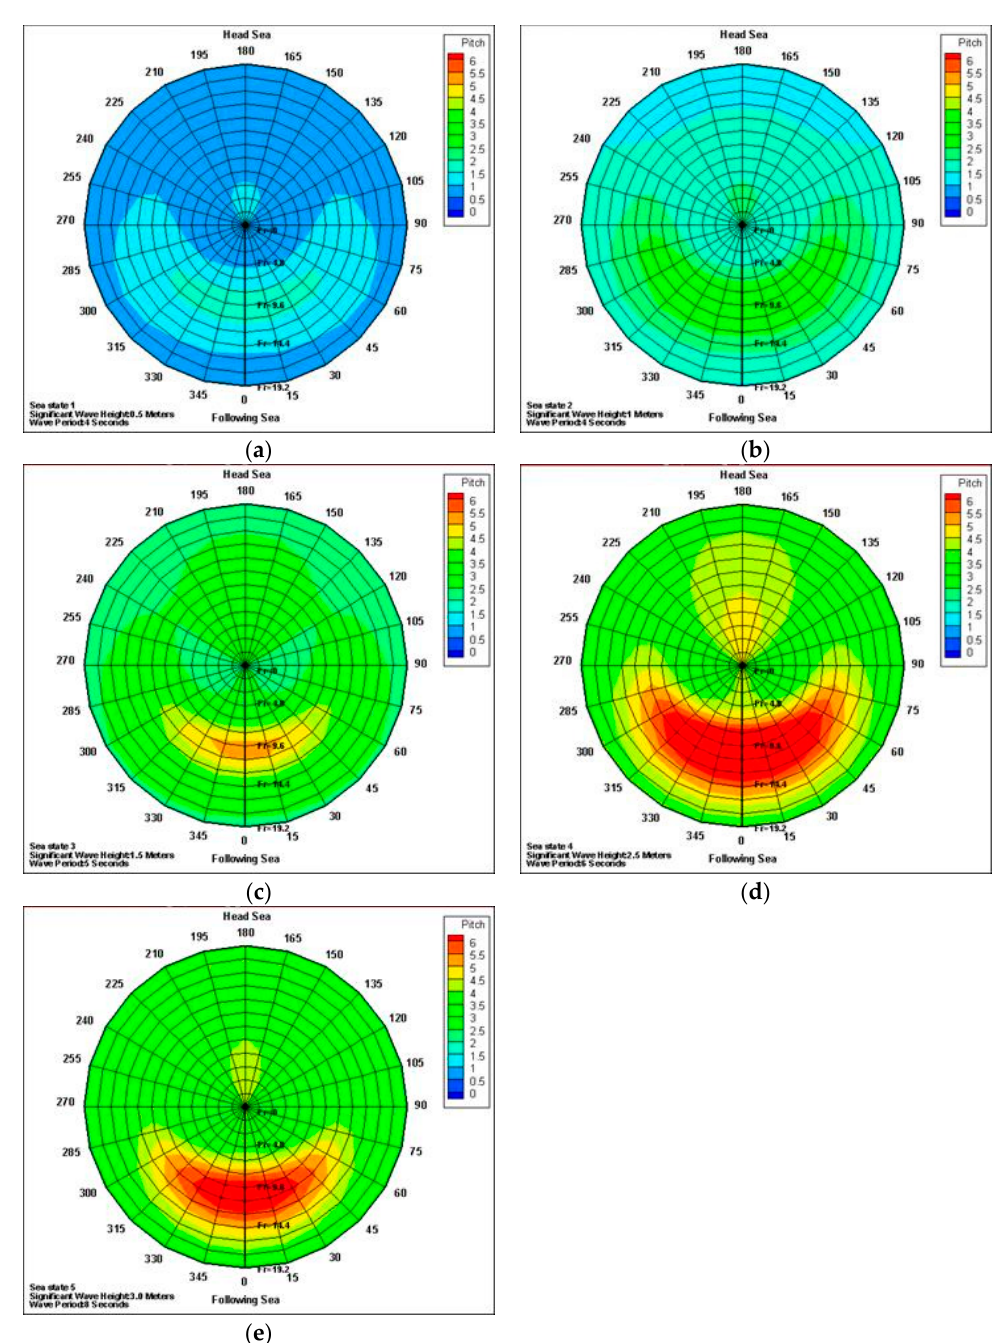
Figure 14. Speed polar diagrams of pitching motion at various sailing speeds for different wave heading angles under sea state ( a ) 1, ( b ) 2, ( c ) 3, ( d ) 4, and ( e ) 5, respectively.